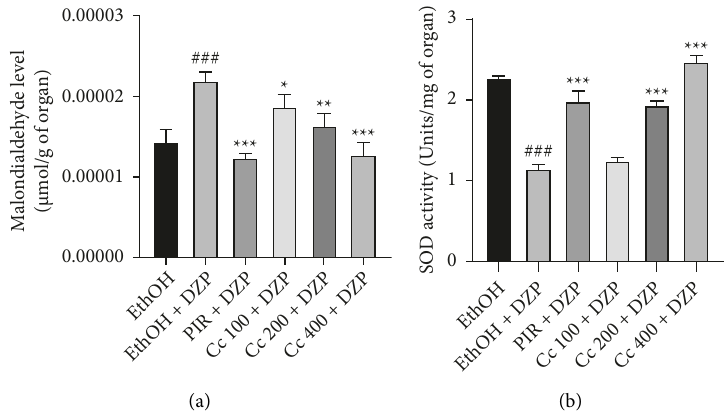
Figure 4: Effect of ethanolic extract of Cc on the malondialdehyde level (a) and superoxide dismutase level (b) in the hippocampus of mice. Bars represent the mean